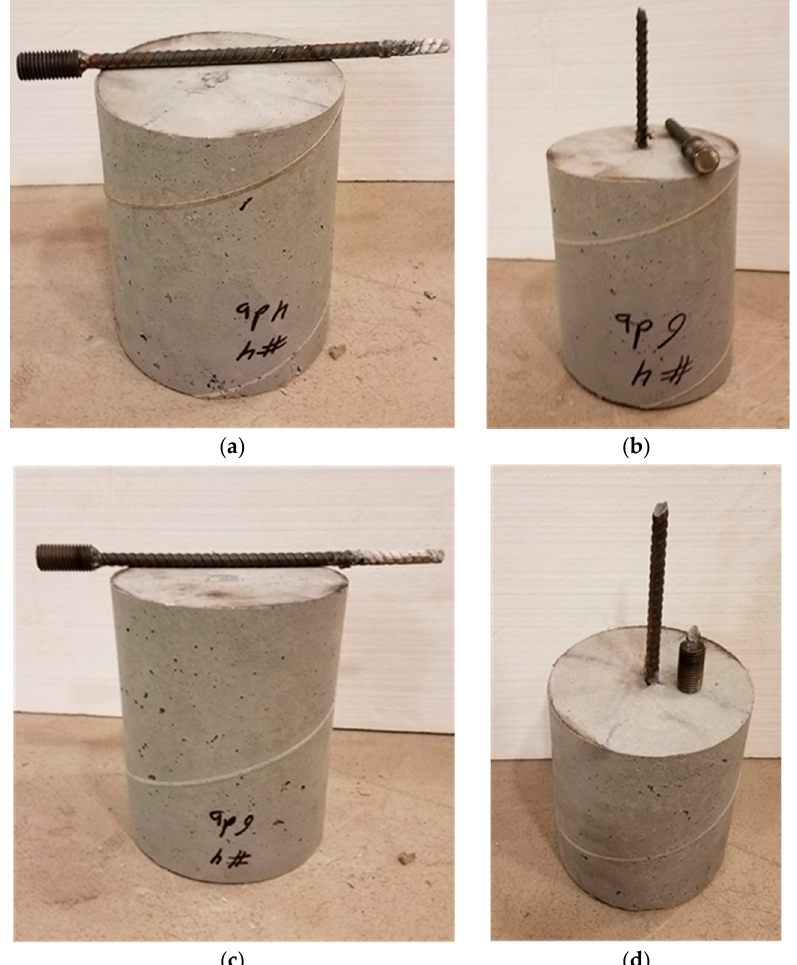
Figure 4. Failure due to: ( a ) Debonding of bar for embedment length 4d b ; ( b ) bar rupture for embedment length of 6d b ; ( c ) Debonding of bar for embedment length of 6d b ; ( d ) bar rupture for embedment length of 10d b (similar failure observed for 8d b ).